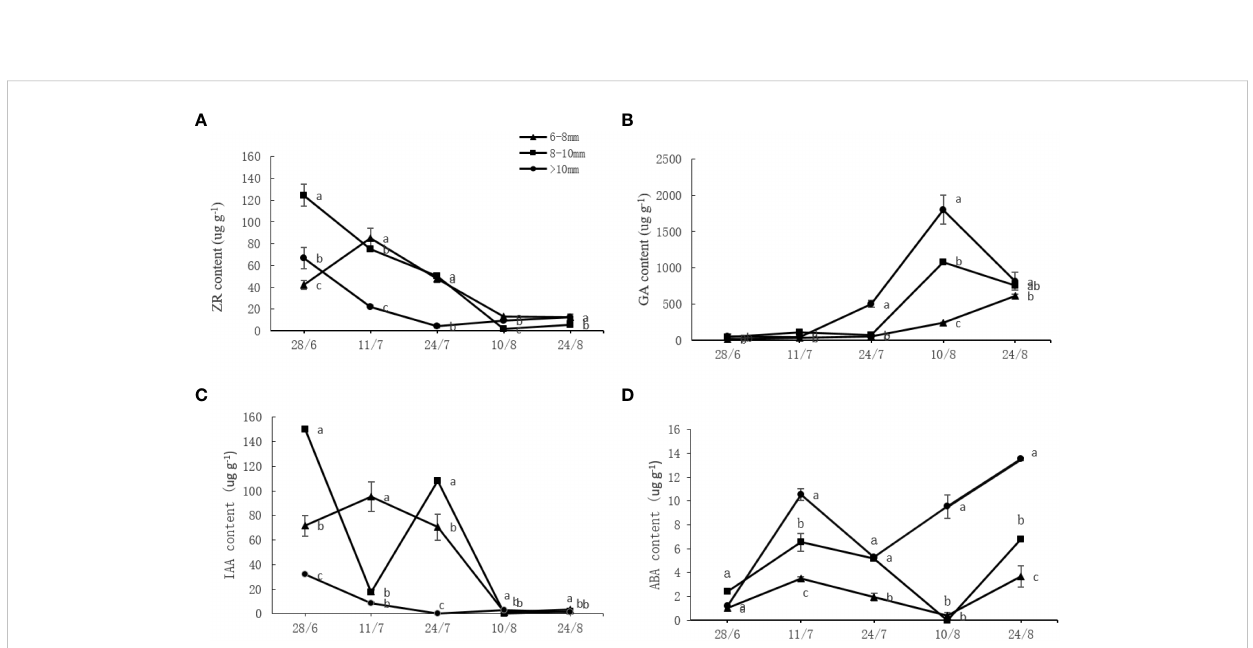
FIGURE 4 Effect of the UST on (A) zeatin riboside (ZR), (B) auxin (IAA), (C) abscisic acid (ABA), and (D) gibberellin (GA) content in buds of the upper canopy. The lower-case letters indicate signi fi cant differences ( P <